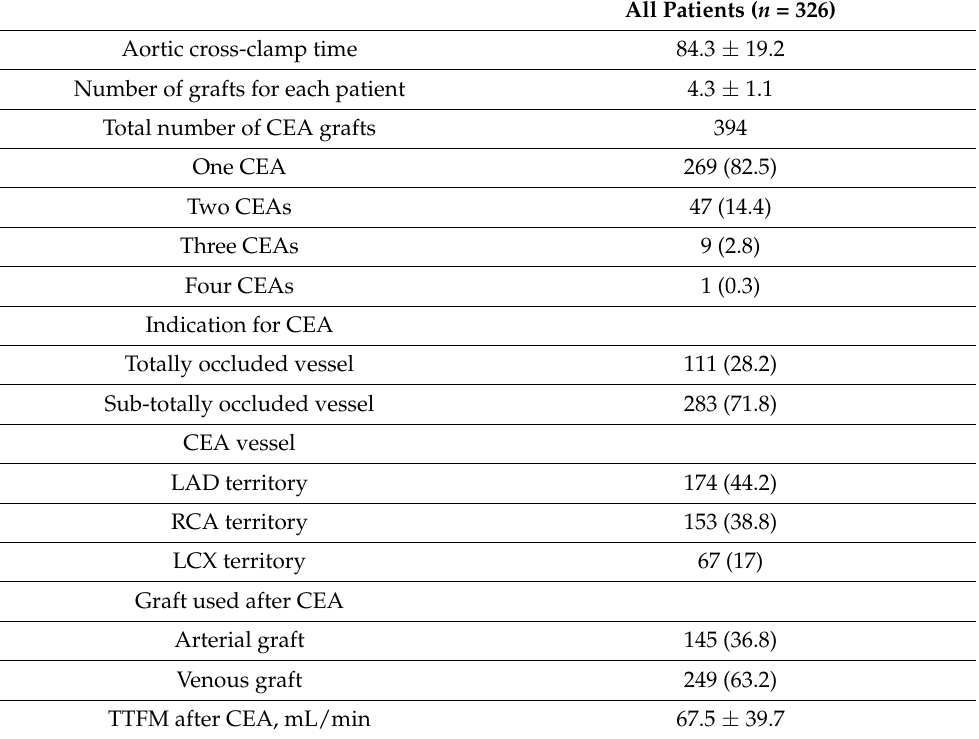
Table 2. Intraoperative outcomes.